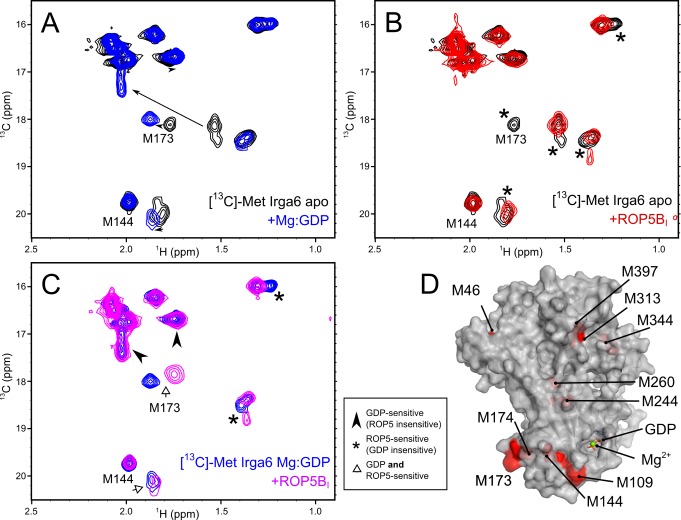
ROP5 binding alters the conformation of the Irga6 active site.(A) HSQC spectra of [13C]-Met labeled Irga6 in the absence (black) or presence (blue) of Mg2+ and GDP. Peaks that shift are indicated with arrows. Peaks that have been assigned by mutagenesis are indicated. (B) HSQC spectra of [13C]-Met labeled Irga6 in the absence (black) or presence (red) of ROP5BI, with no Mg2+ or GDP. Peaks that exhibit chemical shift changes upon addition of ROP5 are starred. (C) HSQC spectra of [13C]-Met labeled Irga6 in the absence (blue) or presence (purple) of ROP5BI, with Mg2+ and GDP. Peaks that are sensitive to only GDP are indicated with a black arrowhead, those sensitive to ROP5 only are starred, and those sensitive to both are indicated with an open arrow. (D) A surface representation of the GDP-bound Irga6 structure. Surface exposed methionines are indicated in red, and buried methionines are shown as red spheres. The bound Mg2+ is shown as a green sphere and the bound GDP as sticks.